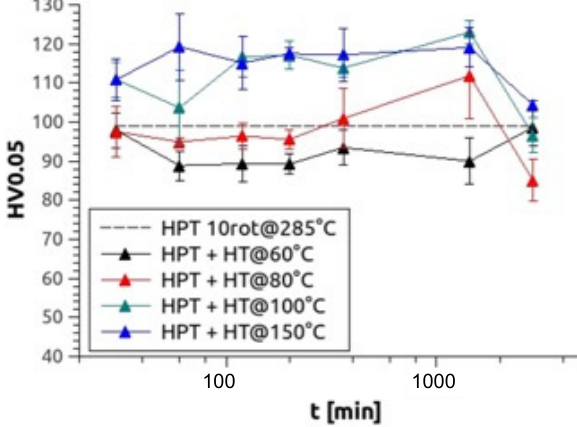
Figure 5. Microhardness results of Mg5Zn0.3Ca, HPT-processed at 4 GPa and 10 rotations at 285 °C and heat treated at 60 °C (black), 80 °C (red), 100 °C (green) and 150 °C (blue) up to 48 h. Table 2. Microhardness values of all investigated alloys in all conditions. HPT has been performed